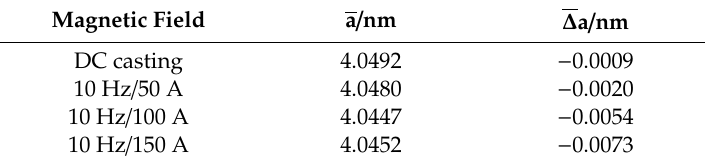
Table 4. E ff ects of electromagnetic field on Lattice parameters of α (Al) of 2A97